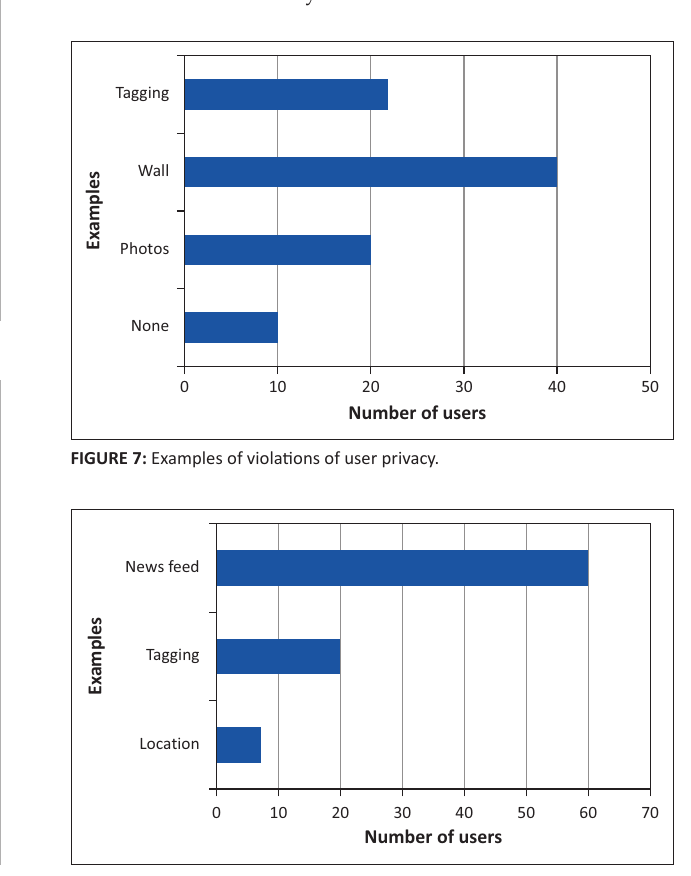
FIGURE 8: Features to be improved